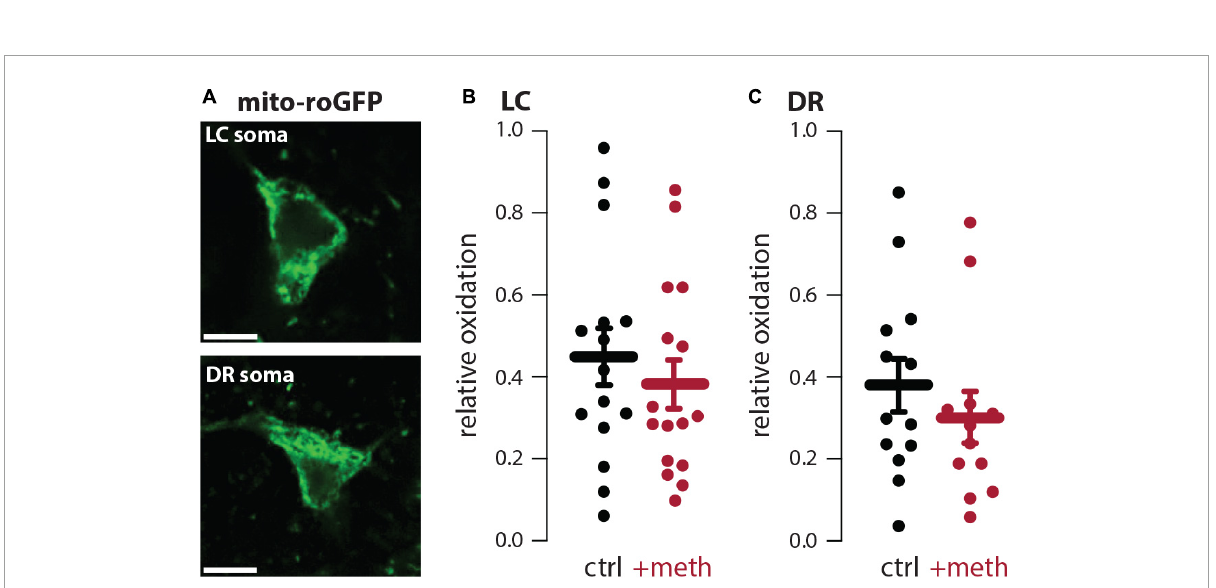
FIGURE2 Meth did not increase somatic mitochondrial oxidant stress in locus coeruleus (LC) or dorsal raphe (DR) neurons. (A) Sample image (top) showing mito-roGFP expressed in the soma of a LC norepinephrine neuron; scale bar denotes 10 µ m. Sample image (bottom) showing mito-roGFP expressed in the soma of a DR serotonin neuron; scale bar denotes 10 µ m. (B) Meth (+meth; 10 µ M) had no effect on somatic mitochondrial oxidant stress in LC norepinephrine neurons; ctrl n = 15 neurons/7 mice, + meth n = 16 neurons/4 mice. Data analyzed using an unpaired t -test [ t ( 29 ) = 0.7229, p = 0.4755, two-tailed]. (C) +meth also had no effect on somatic mitochondrial oxidant stress in DR serotonin neurons (ctrl n = 13 neurons/4 mice, +meth n = 12 neurons/4 mice). Data analyzed using Mann-Whitney test ( U = 61, p = 0.3760,